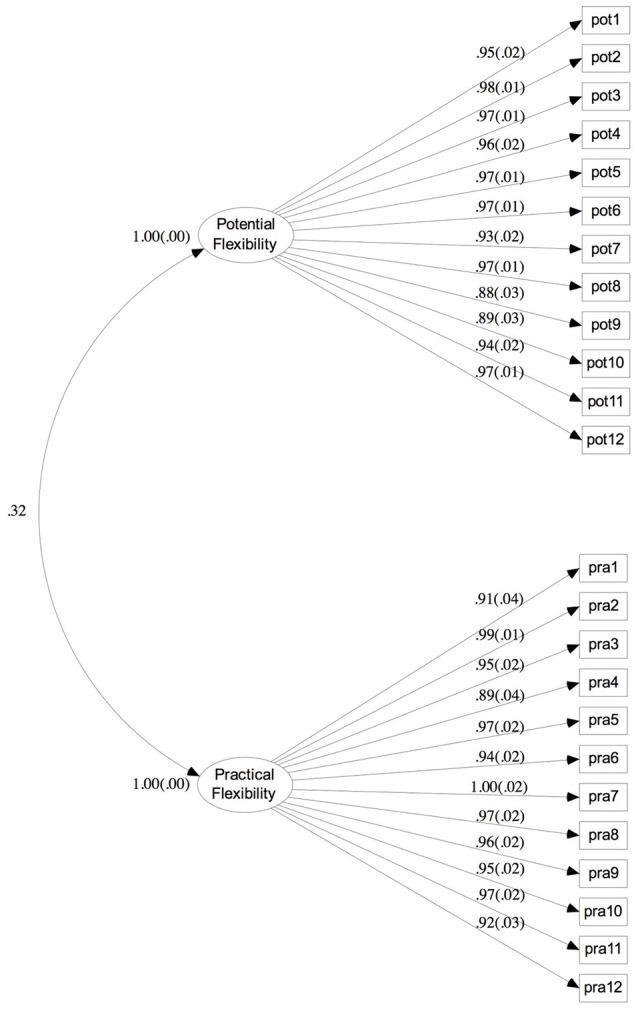
Factor loading and factor intercorrelations for potential flexibility and practical flexibility. All estimated coefficients are significant with p < 0.001. Pot, Potential Flexibility Item; Pra, Practical Flexibility Item.